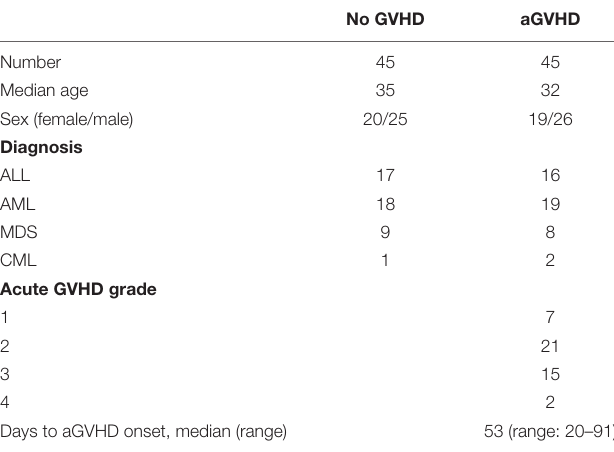
TABLE 1 | Clinical characteristics of